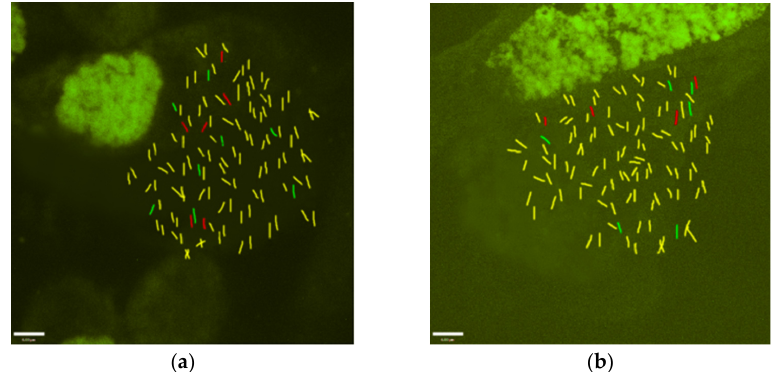
Plants 2023 , 12 , 810